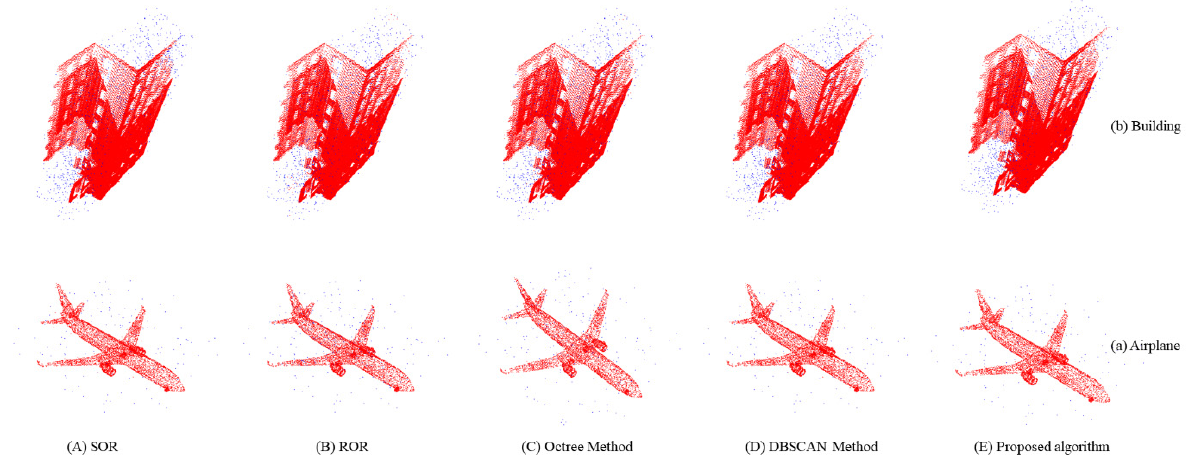
Figure 7. Large-scale noise filtering effects. ( a ) are Airplane point cloud; ( b ) are Building point